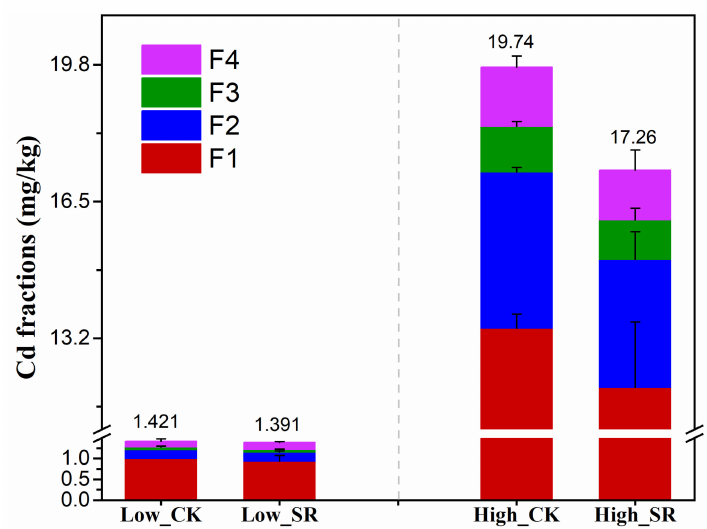
Figure 3. Cd fractions in soils after pot experiments. T signs presented on every bar mean error bars. Low_CK: low contaminated soil + distilled water; Low_SR: low contaminated soil + re-suspended